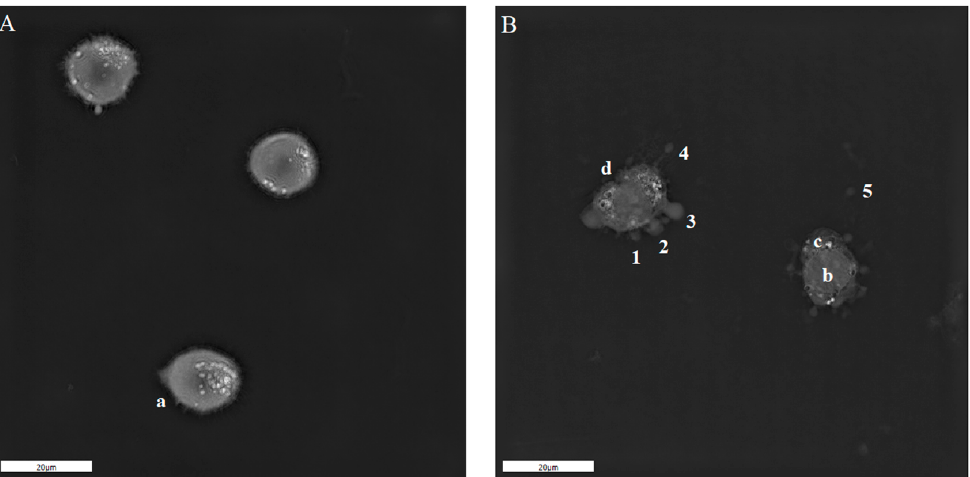
Figure 5. Holotomographic microscopy studies of A375 cells after 4 kV/cm, 8 pulses, 0.1 ms pulse duration treatment. Photograph on the left side shows the normal morphology and filopodia of the cells suspended in the EP buffer ( A ). Photograph on the right side of the figure ( B ) presents blebbing cells after 4 kV/cm, 0.1 ms PEF treatment. 1, 2, 3—evolution of the blebs, 4—bleb release from the membrane, 5—free bleb outside the cell; a—filopodia, b—nucleus, c—cytoplasm, d—membrane invagination; scale bar—20 μ m.